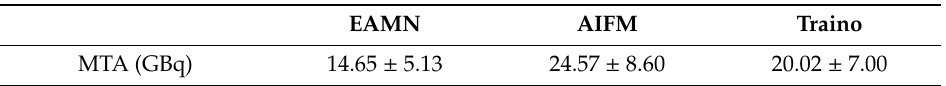
Table 4. Maximum tolerated activity (MTA) values derived from the di ff erent dosimetric approaches using 2 Gy as the limit for blood or red marrow absorbed dose.